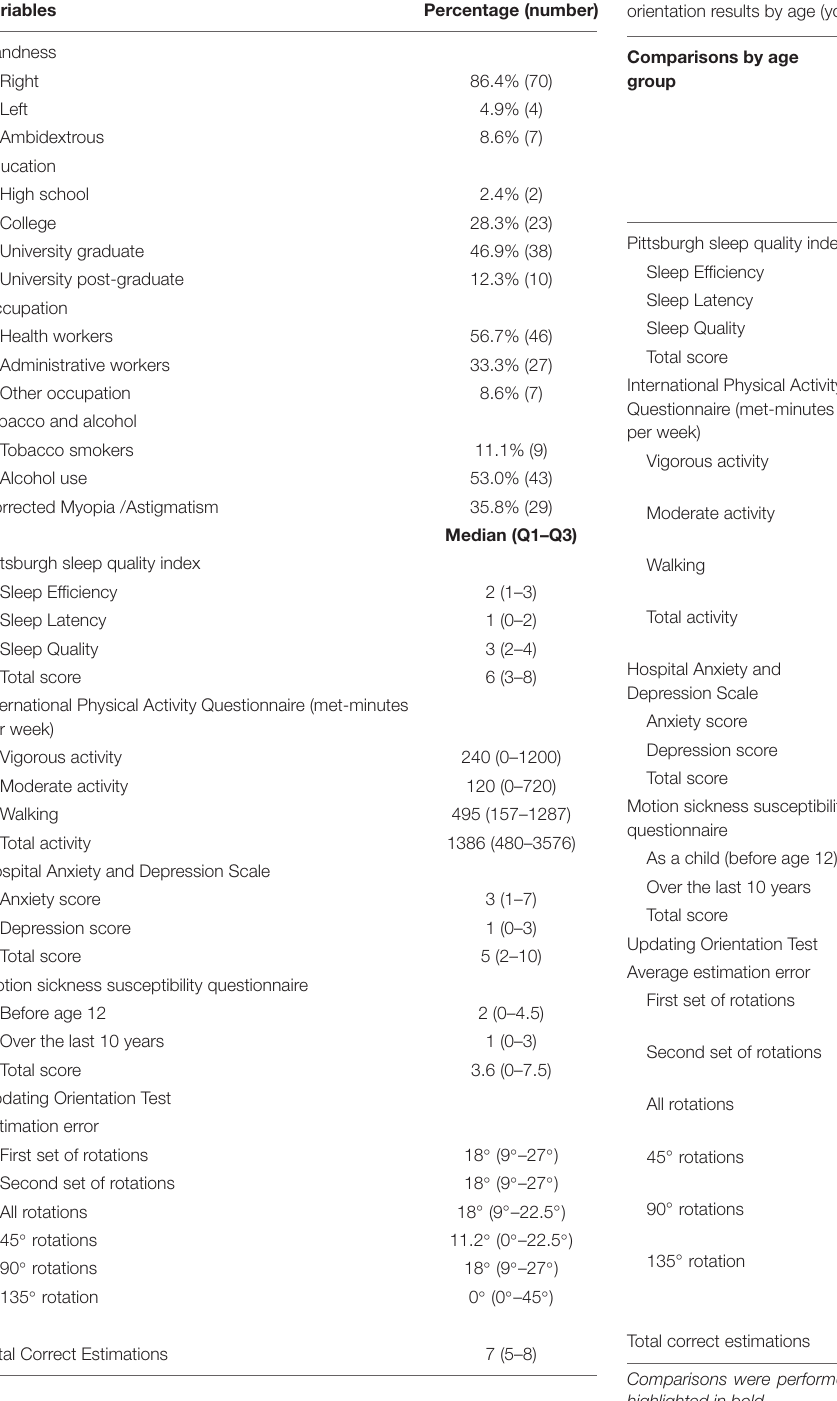
TABLE 2 | Median, Quartile 1 (Q1) and Quartile 3 (Q3) of the Pittsburgh sleep quality index, International Physical Activity Questionnaire, Hospital Anxiety